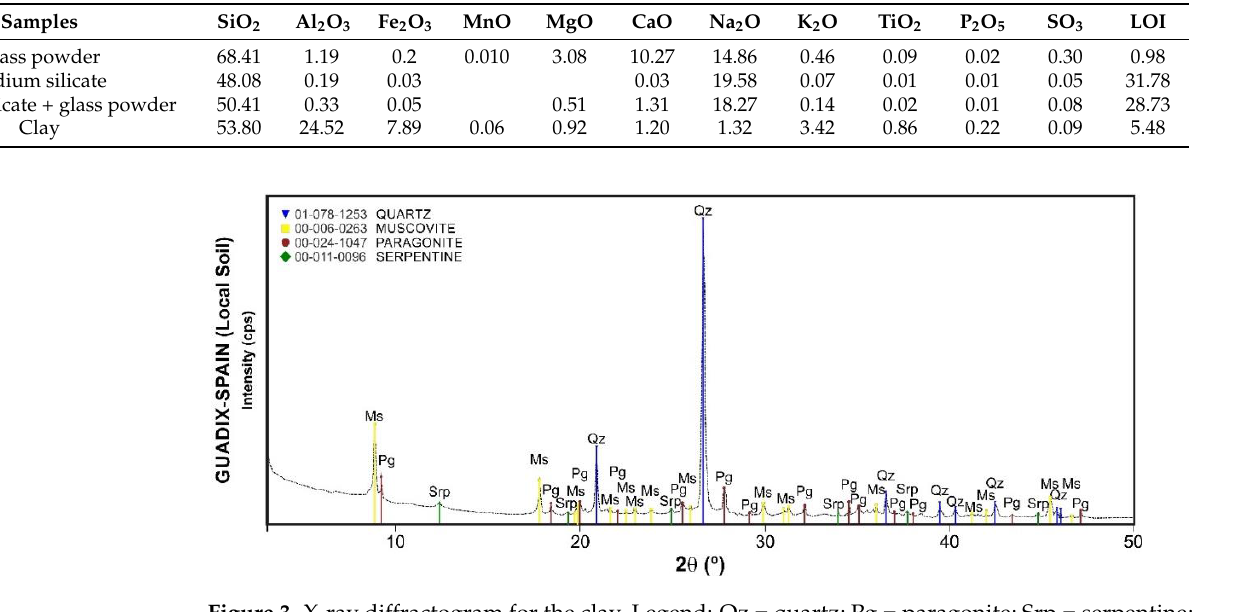
Figure 3. X-ray diffractogram for the clay. Legend: Qz = quartz; Pg = paragonite; Srp = serpentine; Ms = muscovite. Table 2. XRF analysis of raw materials (wt %). Data normalized to 100% (LOI-free).